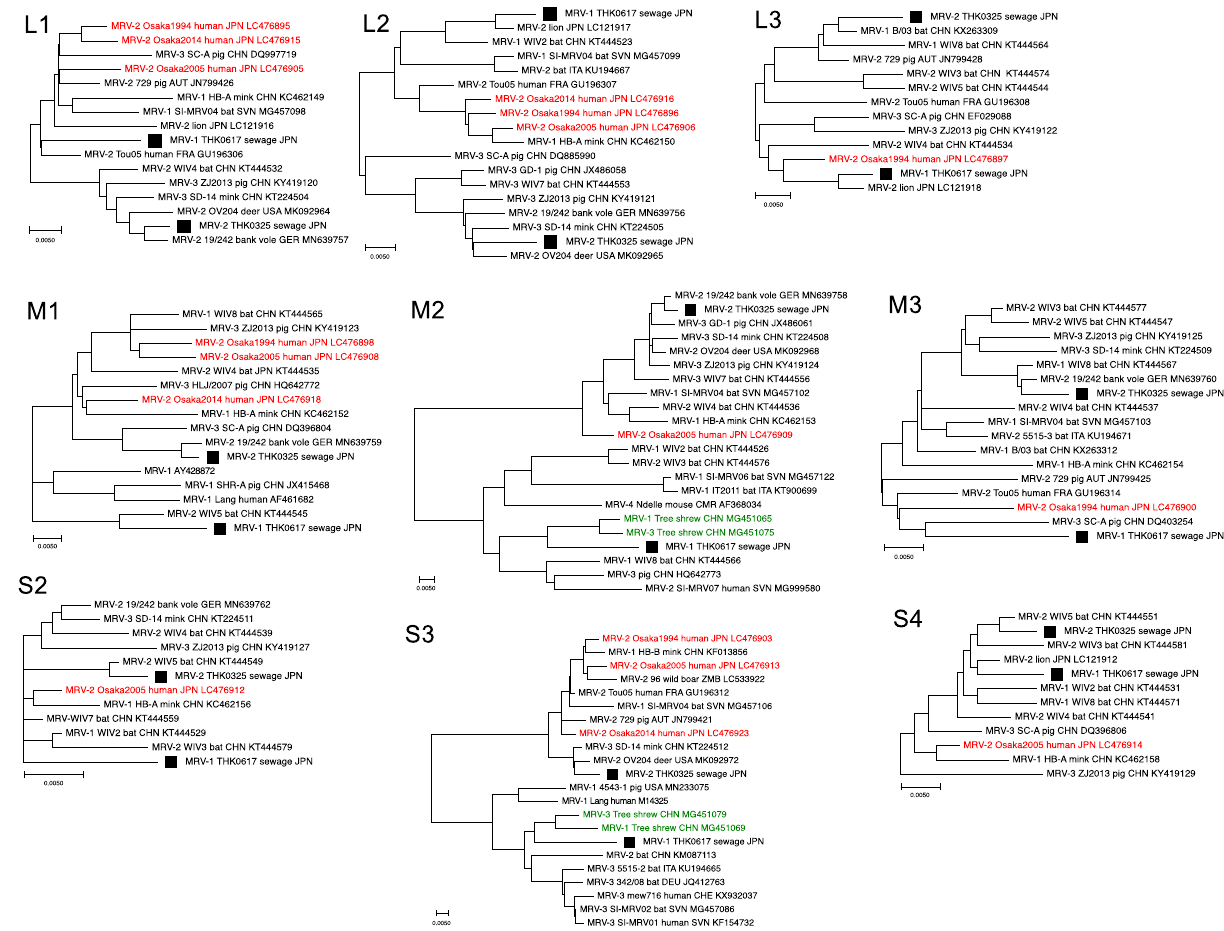
Figure 3. Phylogenetic analysis based on the nucleotide sequences of MRV isolates. Phylogenetic trees for segments aside from S1 were constructed through the maximum-likelihood method and 1000 bootstrap replicates using MEGA software. MRV sequences obtained from the GenBank database based on the best hits retrieval of the BLAST result. Each ID depicts the MRV genotype, name, host species, country, and accession number. Solid square: the isolates in this study. Red: MRV-2 Osaka strains. Green: MRV-1/TS/2011 and MRV-3/ TS/2012. Scale bar: genetic distances (nucleotide substitutions per